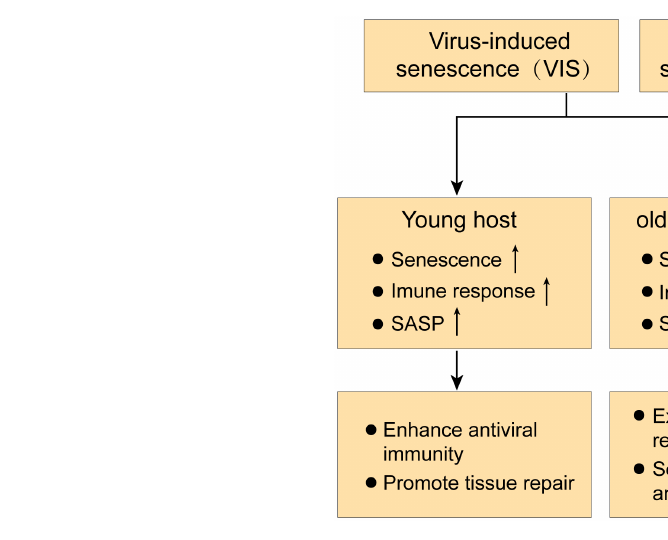
FIGURE 3 Dual role of senescence in antiviral immune responses.